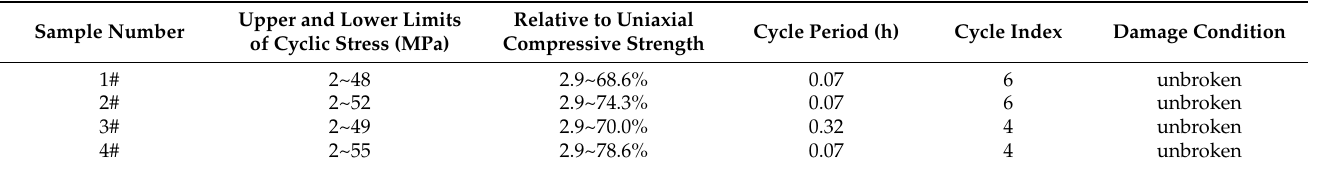
Table 3. Experimental parameters and results of mud shale compression under cyclic